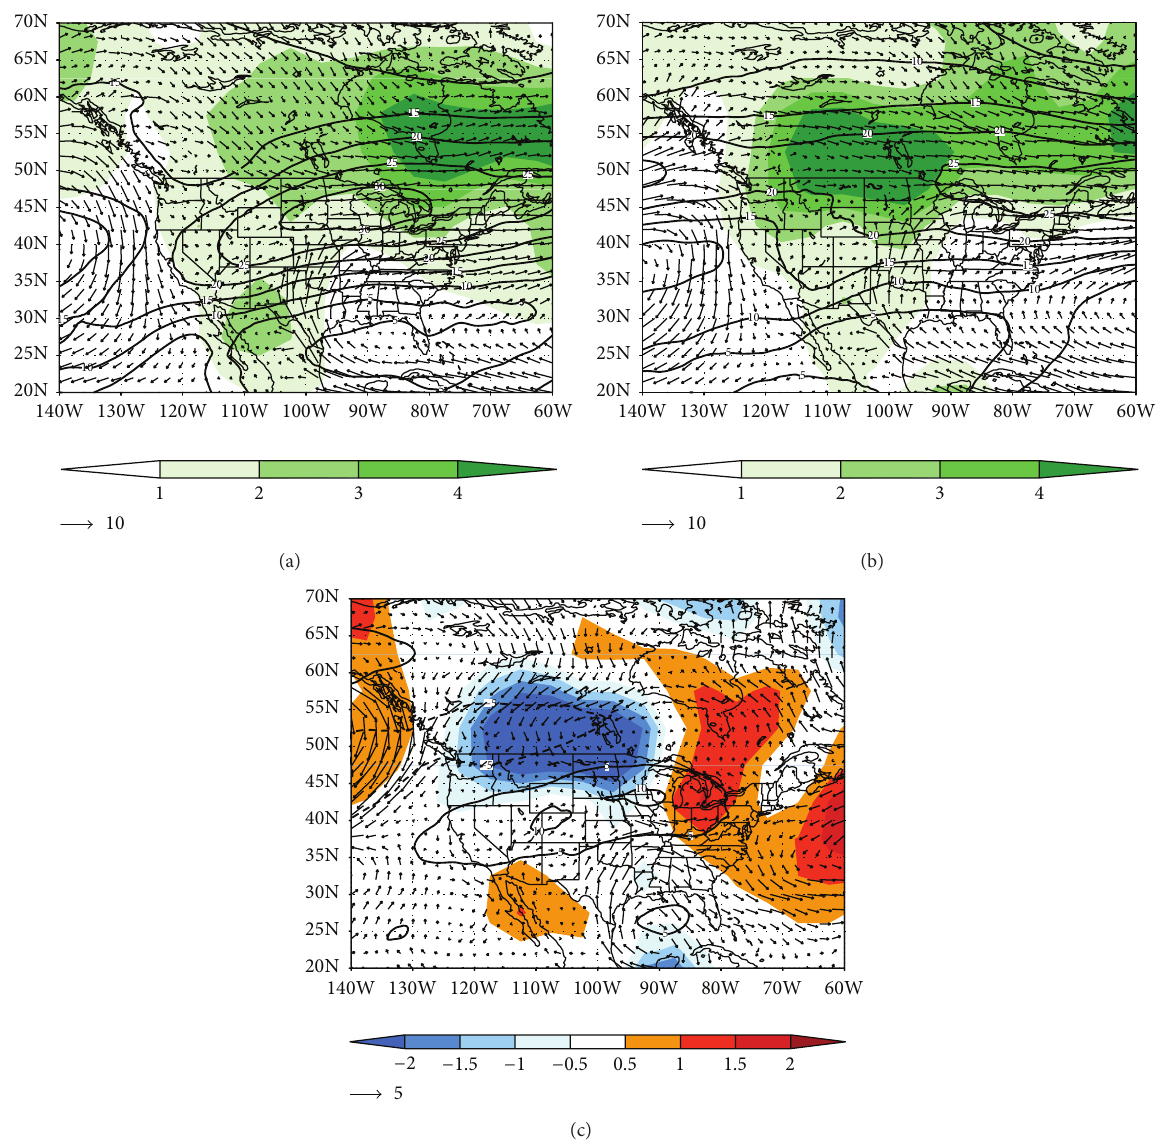
Figure 6: 200 hPa wind (contour, m/sec), cyclone frequency (shaded), and 850 hPa wind (vector, m/sec) for (a) JAS93, (b) JAS88, and (c) JAS93 minus JAS88. Data from